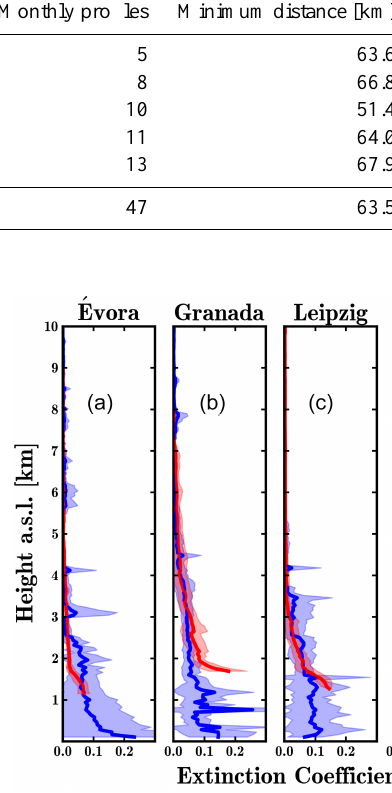
Figure 3. Extinction coefficient at 532nm for CL3 ∗ (blue line) and for EARLINET (red line). From left to right: (a) Évora, (b) Granada, (c) Leipzig, (d) Naples, and (e)